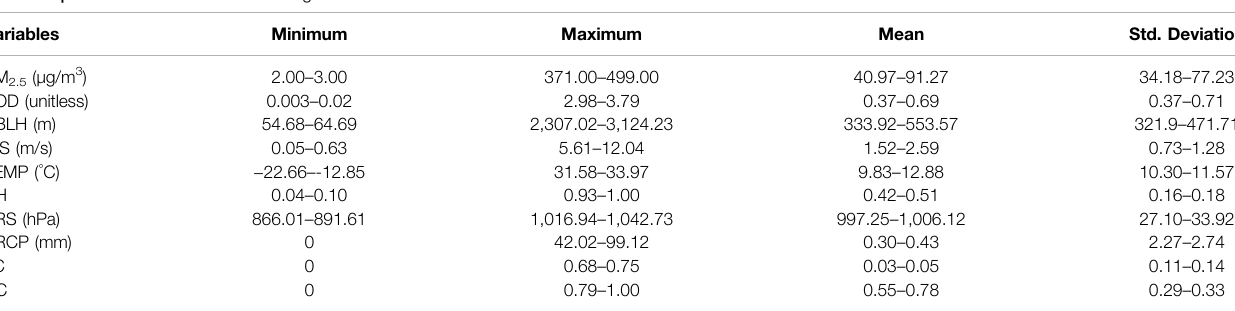
TABLE 3 | Statistical indicators of modeling variables.